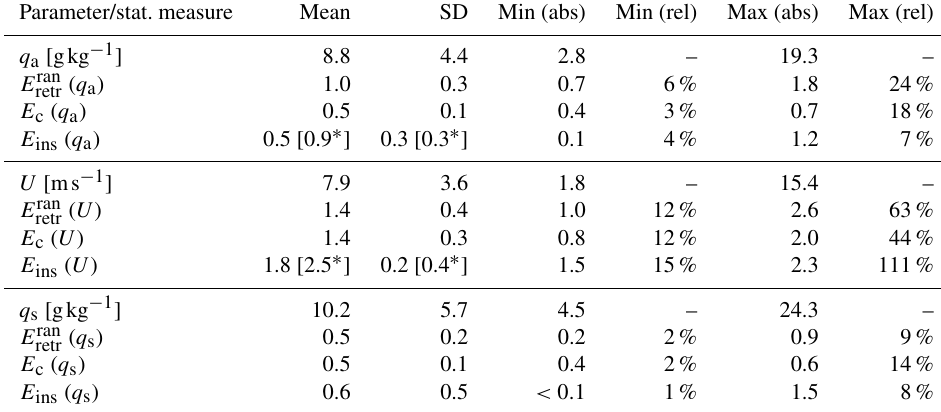
Table 1. Absolute and relative random statistical measures resulting from the multi-dimensional LUTs, i.e. MTC and random uncertainty decomposition (Sects. 3.2 and 3.3). “SD” is standard deviation, “abs” is absolute, and “rel” is relative. Apart from the LHF-related bulk parameters themselves ( U , q s , and q a ), global mean ranges of the random retrieval ( E ran retr ), random collocation ( E c ), and random in situ measurement uncertainty ( E ins ) are shown. Relative measures result from bin-wise relative uncertainty calculations. For comparison, the asterisks indicate respective estimates published in Kent and Berry (2005), which are based on a semivariogram approach. Parameter/stat. measure Mean SD Min (abs) Min